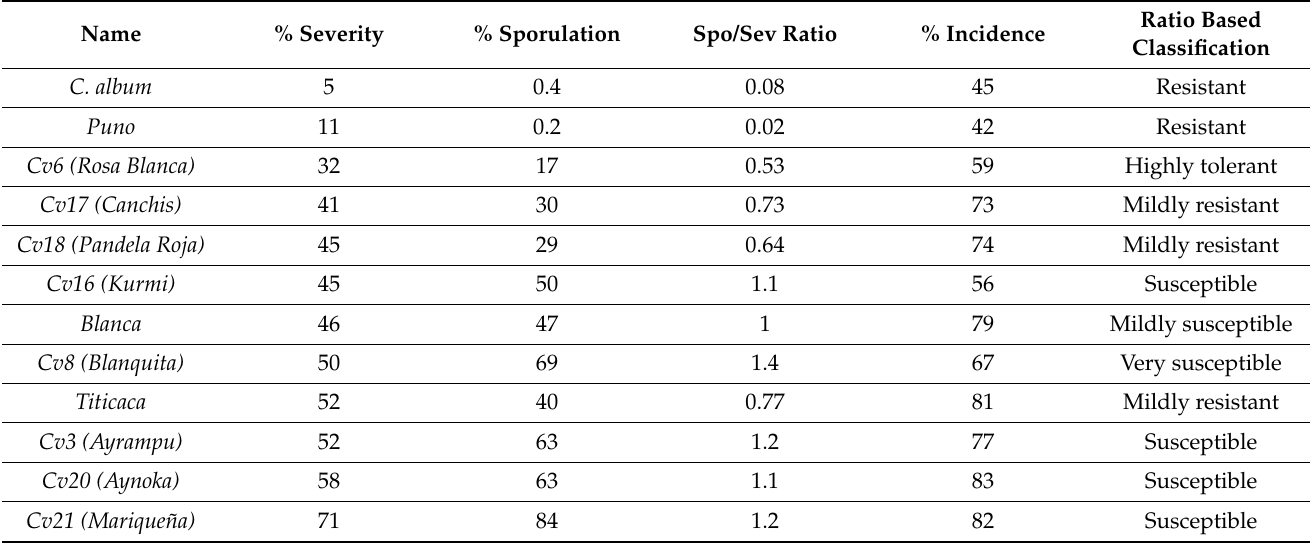
Table 5. Phenotypic infection traits and Ratio for representative cultivars and reference varieties.